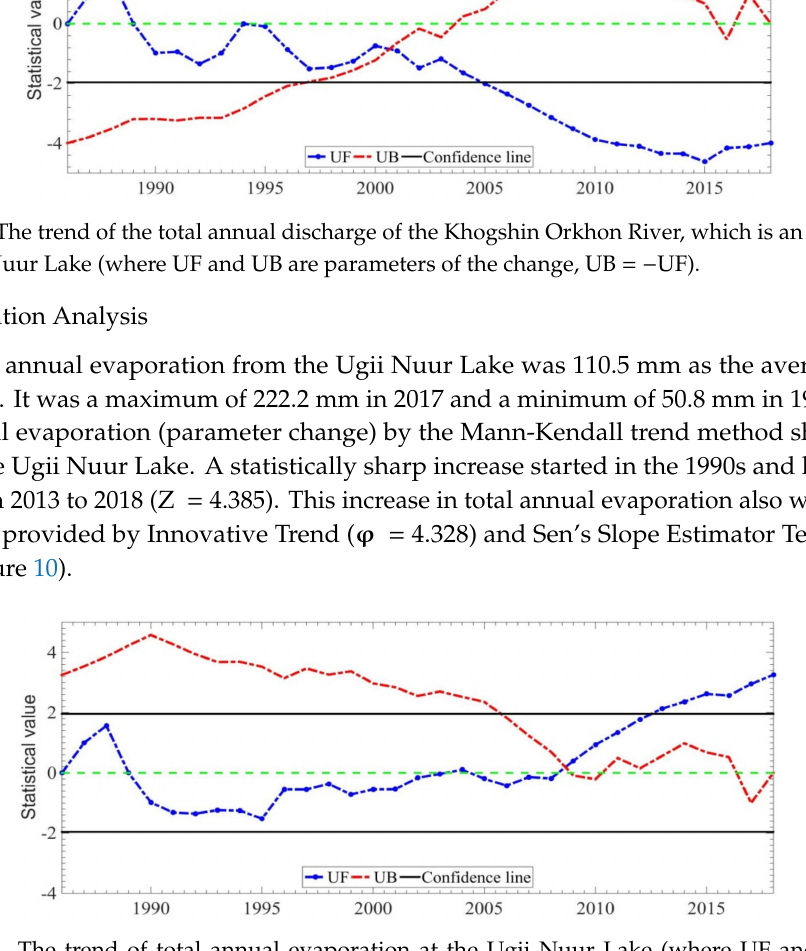
Figure 10. The trend of total annual evaporation at the Ugii Nuur Lake (where UF and UB are parameters of the change, UB = −